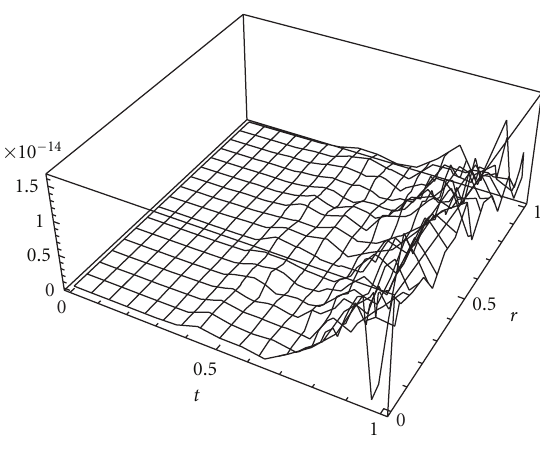
( t , r ) for (cid:2) = − 1 . 02698. 10